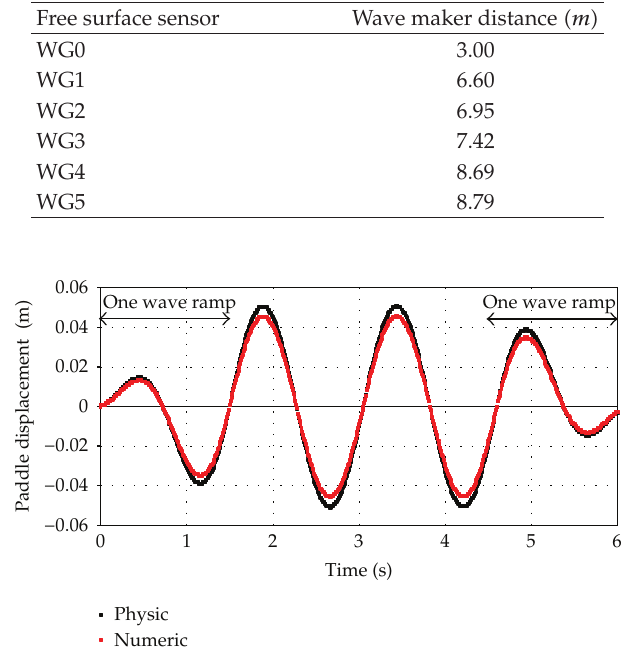
Figure 2: Physical and numerical paddle displacements for wave case 1 defined by H (cid:9) 0 . 06m and T (cid:9) 1 .